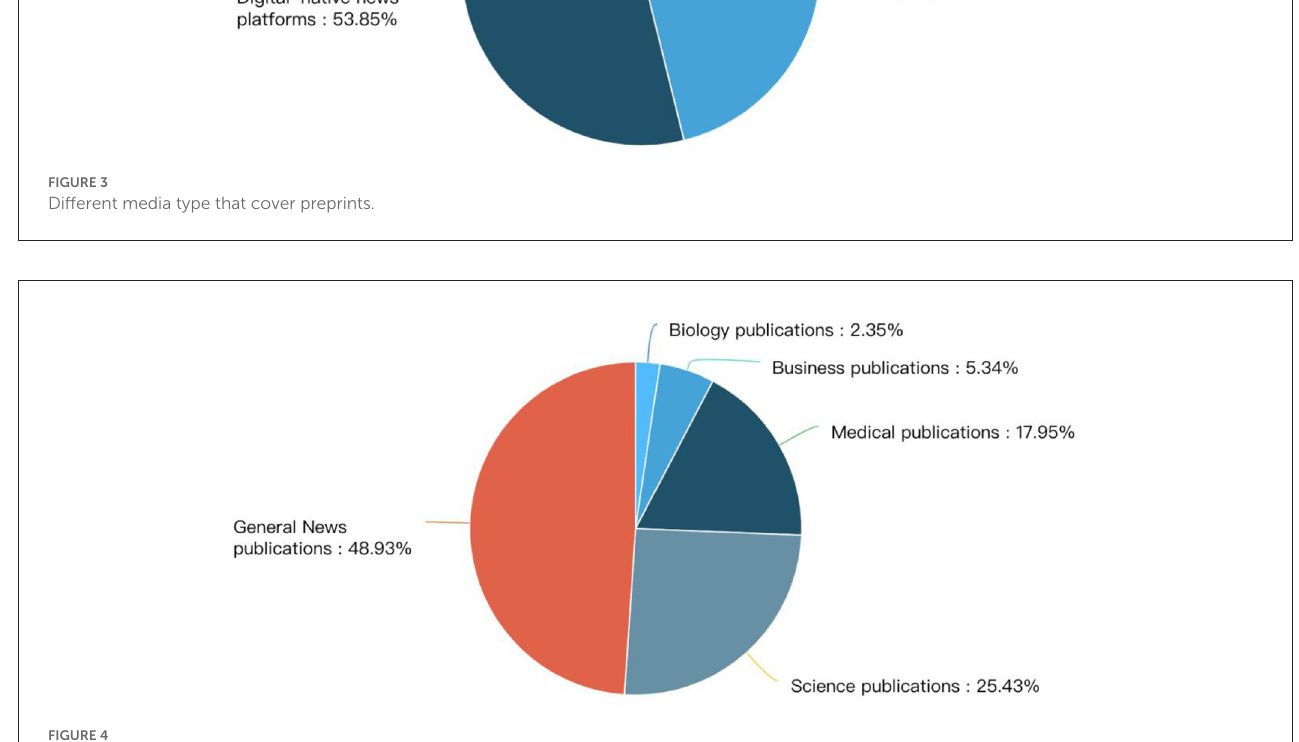
FIGURE4 Different media content that cover preprints.